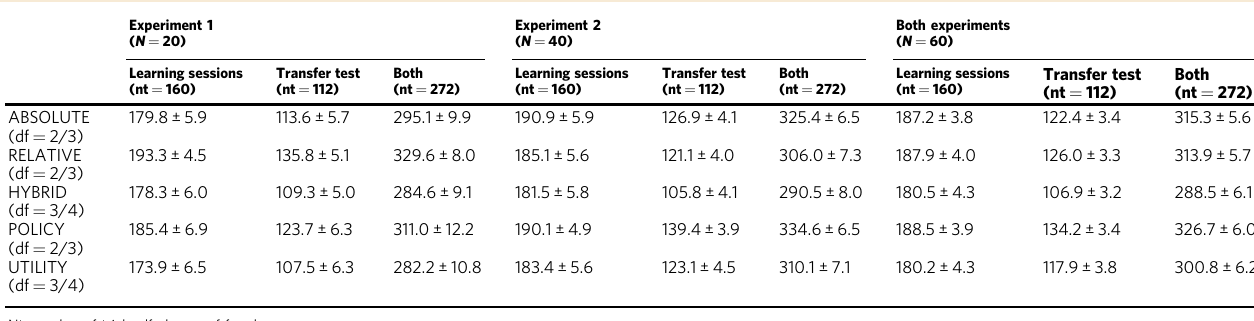
Table 3 BICs as a function of the dataset used for parameter optimization (Learning sessions, Transfer test or Both) and the computational